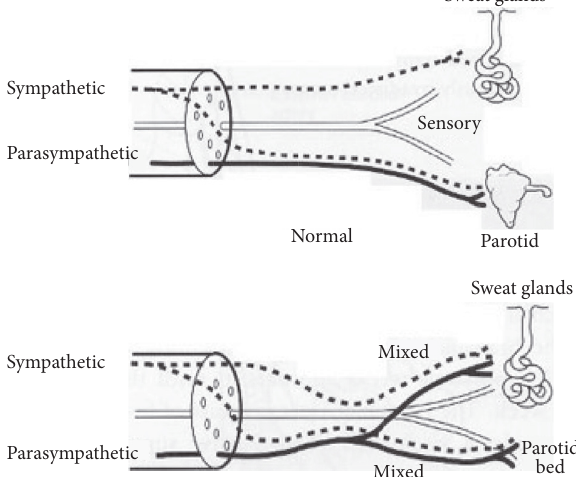
Figure 2: Pathophysiology